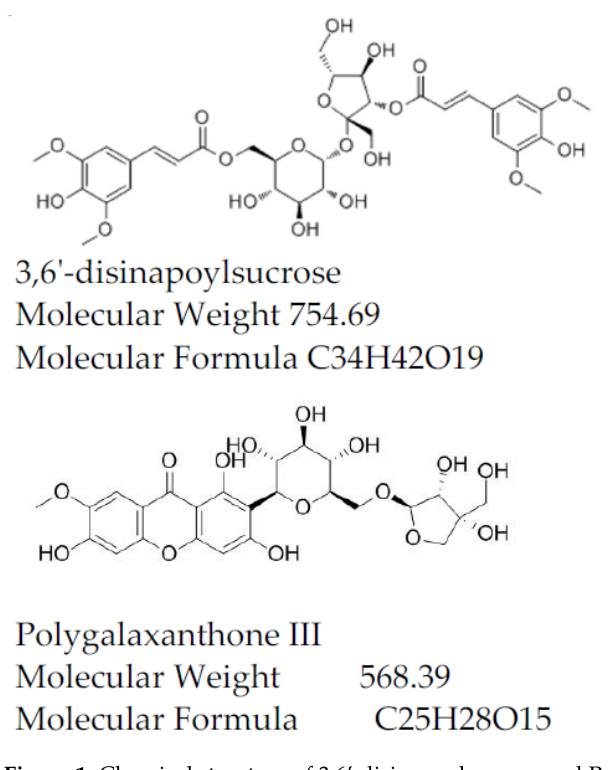
Figure 1. Chemical structure of 3,6’-disinapoylsucrose and Polygalaxanthone III.